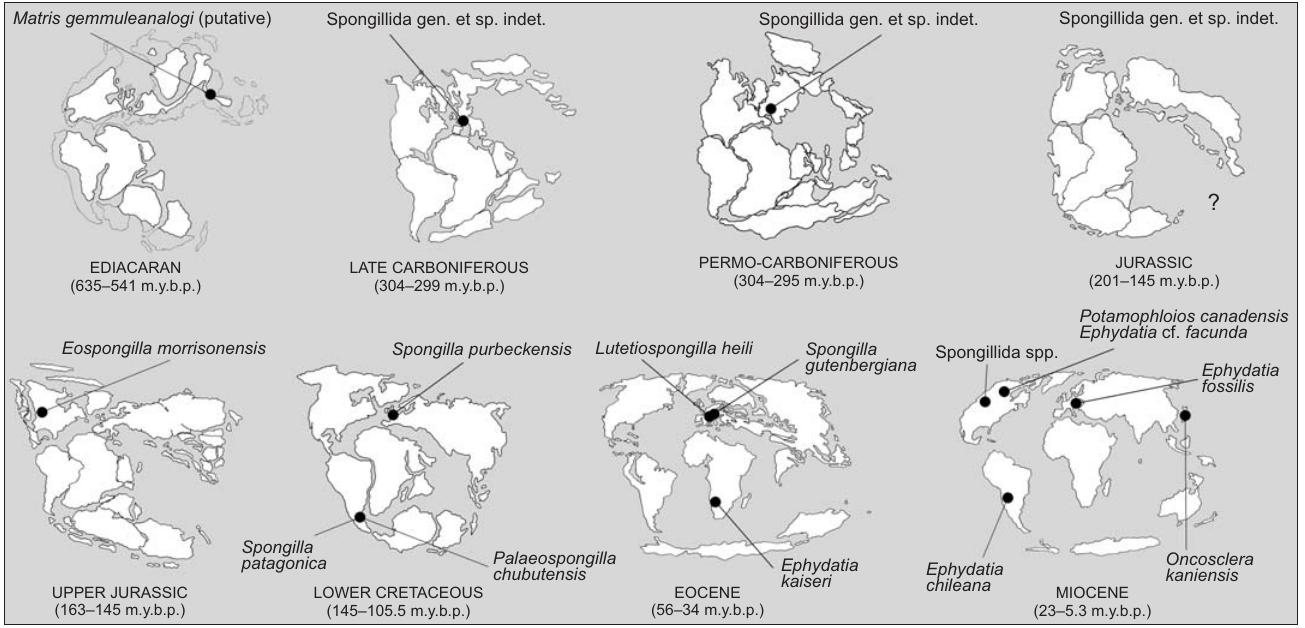
Fig. 7. Palaeogeographic distribution of fossil freshwater sponges (Porifera, Demospongiae,